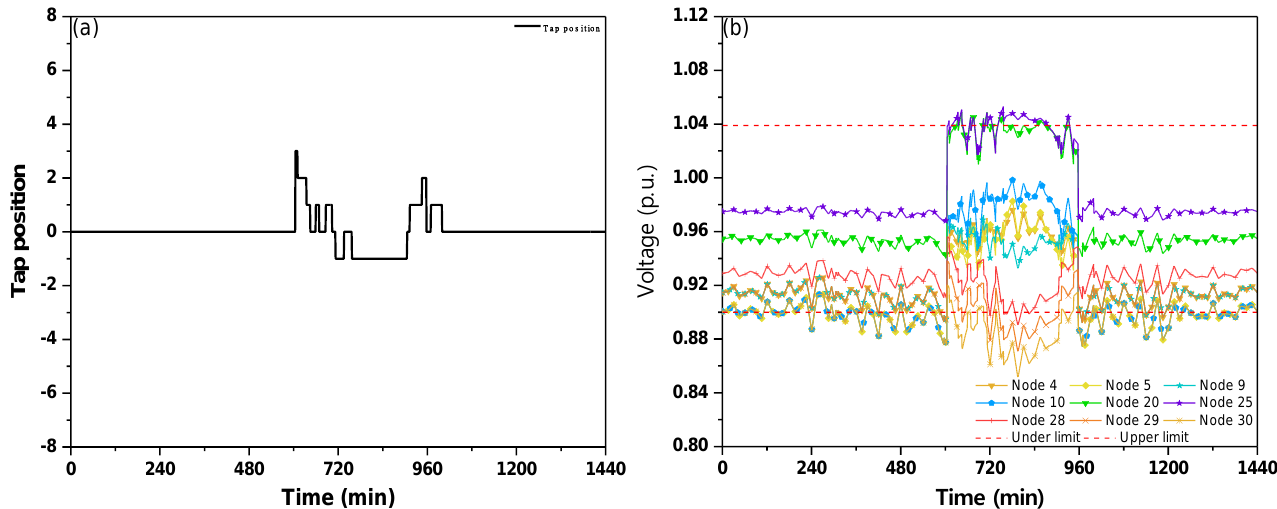
Figure 11. Simulation results of Case 4: ( a ) tap position and ( b ) feeder voltages.